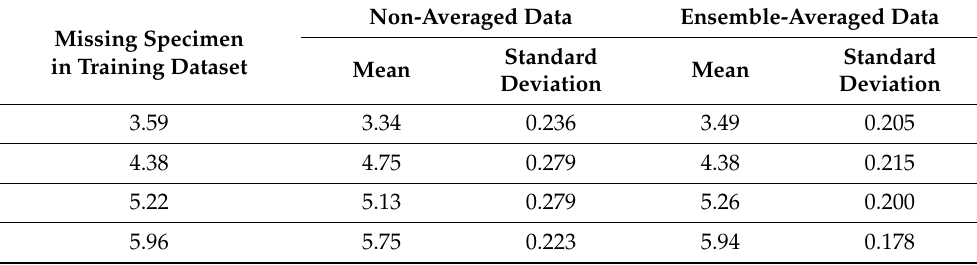
Table 4. Mean and standard deviation of the prediction values for the missing specimen of the model trained with the raw data and the ensemble-averaged data without one specimen. Missing Specimen in Training